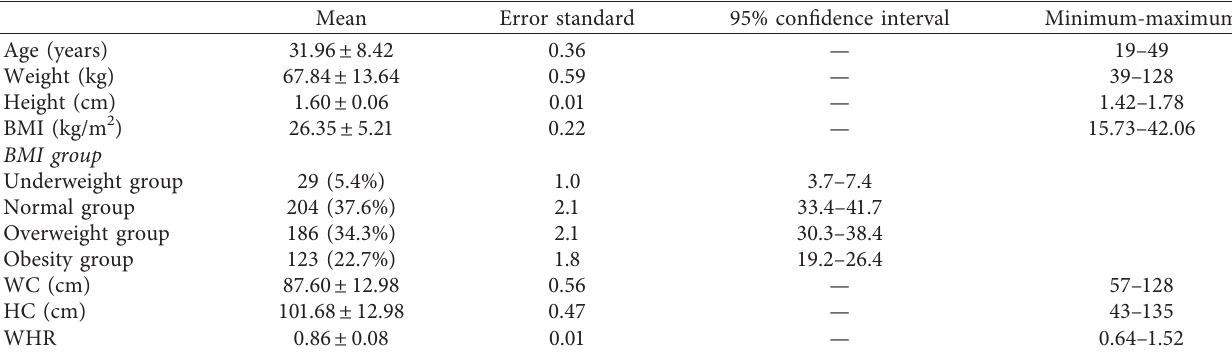
Table 2: Age and anthropometric characteristics of the study population.